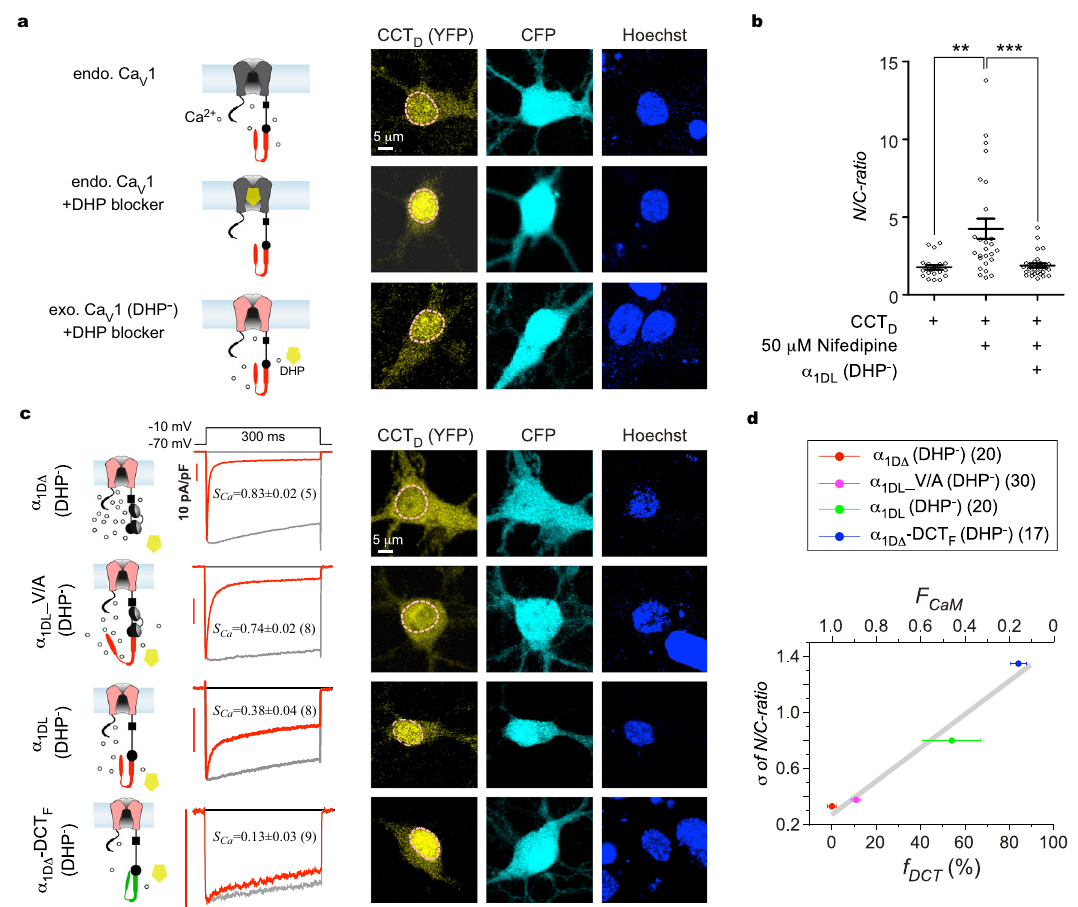
Fig. 7 Unique importance of Ca V 1 to subcellular DCT distributions in neurons unveiled by CMI. a , b Effects of dihydropyridine (DHP). As shown in the cartoon ( a , left), endogenous Ca V 1 channels in cortical neurons mediate Ca 2 + in fl ux (upper); DHP (50 μ M nifedipine) speci fi cally blocked cortical Ca V 1 channels thus reducing Ca 2 + in fl ux (middle); and overexpression of α 1DL (DHP - ) channels (mutant Ca V 1.3 insensitive to DHP) rescued Ca 2 + in fl ux in the presence of 50 μ M nifedipine (bottom). Exemplary fl uorescence confocal images through three channels: YFP (CCT D distribution), CFP (cell contour) and Hoechst (nuclear envelop) ( a , right). N/C ratios of individual neurons from the three groups: control, DHP, and α 1DL (DHP - ) with DHP ( b ). c Ca V 1 variants containing DCT of different potency regulated cytosolic-nuclear distribution of CCT D . In addition to CCT D , cortical neurons were overexpressed with one of the four DHP-resistant Ca V 1.3 variants: α 1D Δ (lacking DCT), α 1DL _V/A (with the key mutation of Valine to Alanine at DCRD), α 1DL (control), and α 1D Δ -DCT F (chimera with ultra-strong DCT). These Ca V 1.3 variants were characterized by exemplar current traces from HEK293 cells expressing the variants illustrated in the cartoons. Cortical neurons were treated with 50 μ M nifedipine to block endogenous Ca V 1 channels while sparing the exogenous DHP - Ca V 1.3 channels. Confocal images depict cytosolic-nuclear localizations of CCT D peptides in a similar fashion to ( a ). d Correlation between DCT inhibition of each Ca V 1.3 variant and spatial dynamics for CCT D peptides in cortical neurons. DCT/CMI potency (DCT-bound fraction f DCT ) here is directly linked to inactivation (fraction of apoCaM-bound channels, F CaM ): f DCT = 1 − F CaM (Eq. E5 in Methods). DCT/CMI potency and standard deviation of CCT D distribution ( σ ) exhibited a tight correlation (linear fi t, R 2 = 0.95). One-way ANOVA followed by Bonferroni for post hoc tests were used for ( b